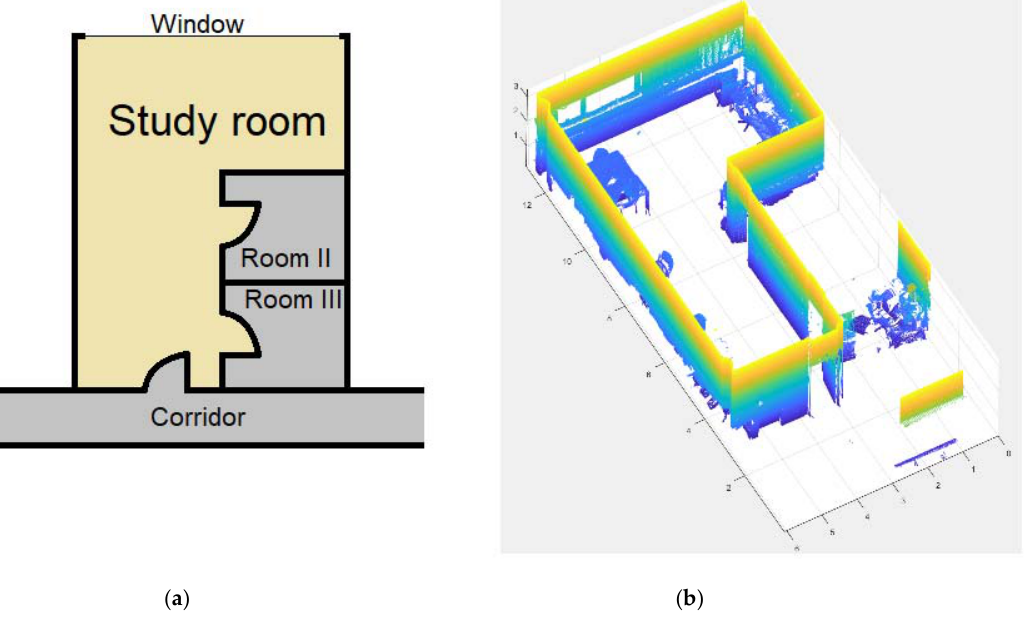
Figure 16. Sketch ( a ) and point cloud ( b ) of the study room (in meters). ISPRS Int. J. Geo-Inf. 2018 , 7 , x FOR PEER REVIEW